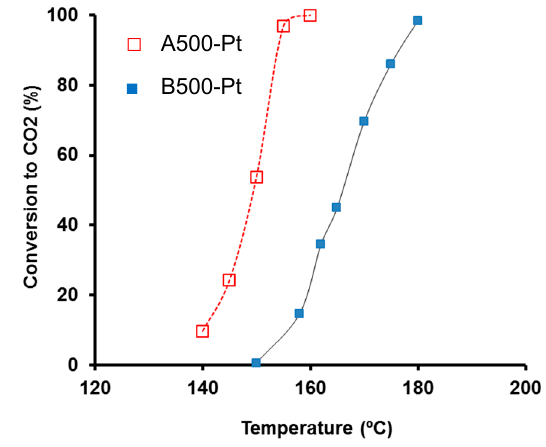
Figure 3. Catalytic performance obtained for supported Pt and Pt-doped catalysts on carbon aerogels in the toluene combustion ([toluene] = 0.45 vol.%, Q = 3.6 L h − 1 , 0.10 g catalyst ). Figure adapted with permission from [56]. Copyright 2004,